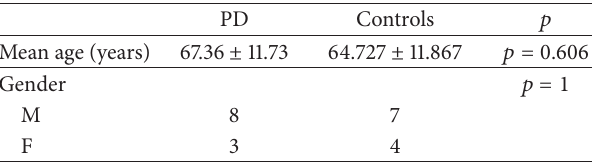
Table 1: Comparison of controls and PD